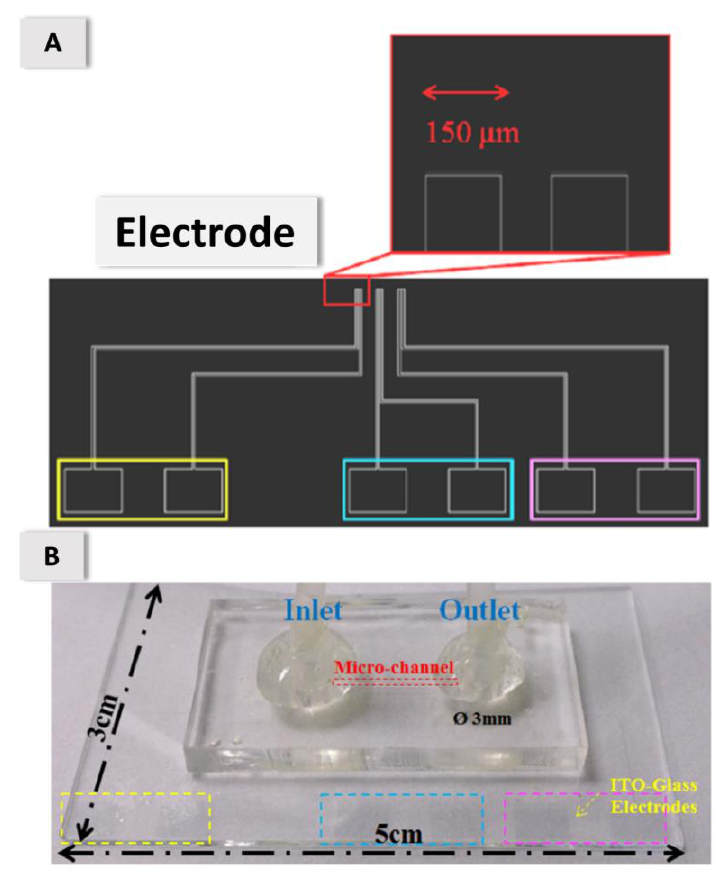
Figure 2. ( A ) Three pairs of parallel linear ITO-glass electrodes. ( B ) Actual device (5 cm × 3 cm). Each gap between the electrodes has width 100 μm; each electrode has width 150 μm.